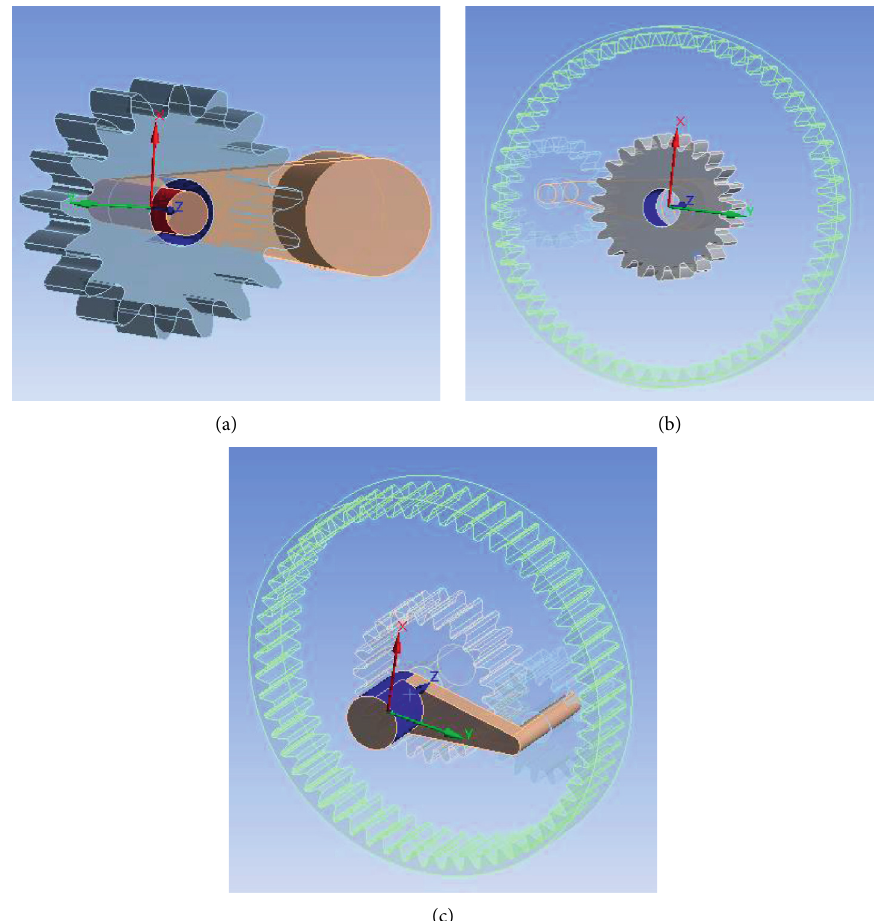
Figure 11: Rotation pairs in planetary gear system. (a) Rotation pairs between planet carrier and planetary gear. (b) Rotation pairs between sun gear and earth. (c) Rotation pairs between planet carrier and